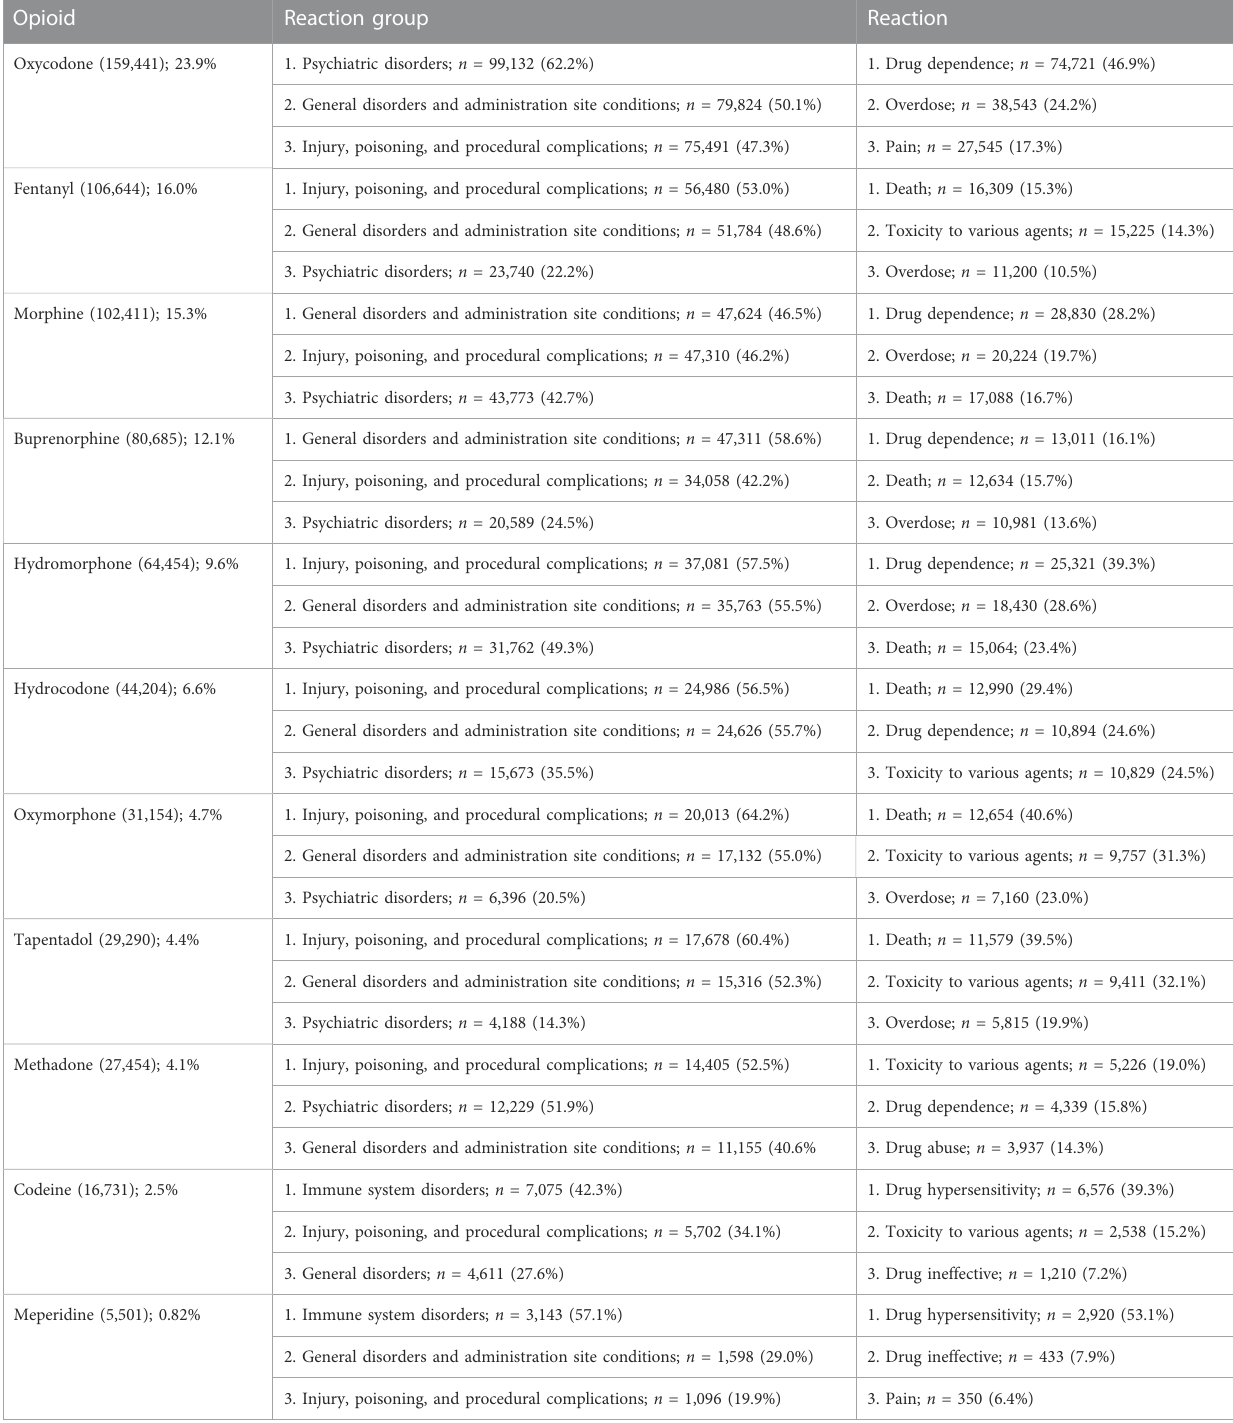
TABLE1AdverseeventreportsbythecountandpercentageintheUSFoodandDrugAdministration ’ sAdverseEffectReportingSystemfor11prescriptionopioids for the 2006 – 2021 period. The three most common reaction groups and reactions are shown. Opioid Reaction group